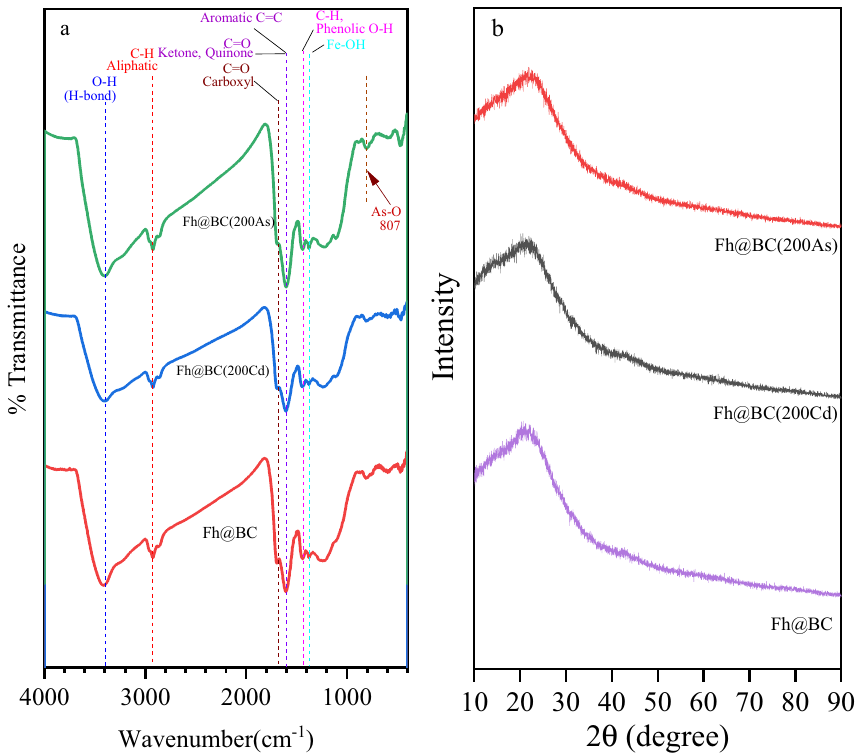
Figure 4. FTIR ( a ) and XRD ( b ) spectrum of Fh@BC before and after the adsorption of As(III) and Cd(II). Fh@BC(200Cd) and Fh@BC(200As) represented the adsorption of Fh@BC for Cd(II) of 200 mg L −1 and As(III) of 200 mg L −1 ,